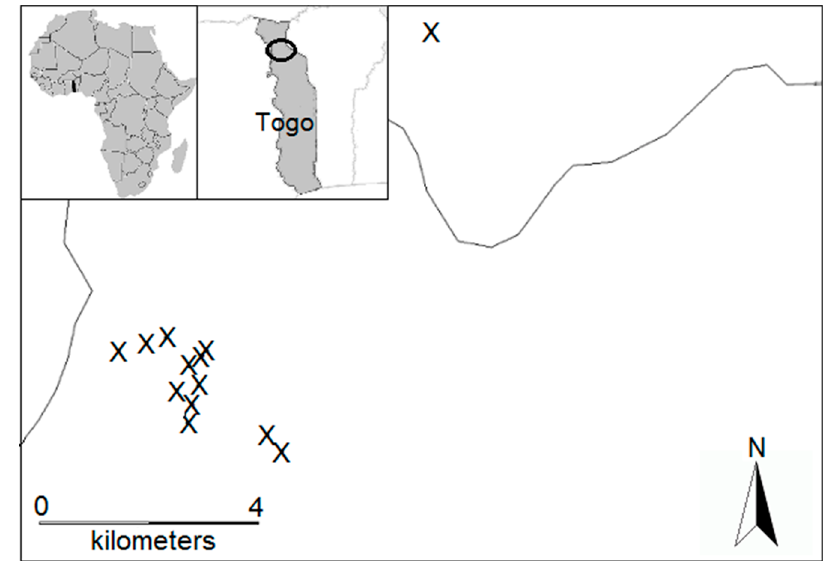
Figure 1. Location of the the Oti ‐ Keran National Park in northern Togo and distribution of the 13 sampled fallows in the study area. Single lines are small roads and the double line in grey is a